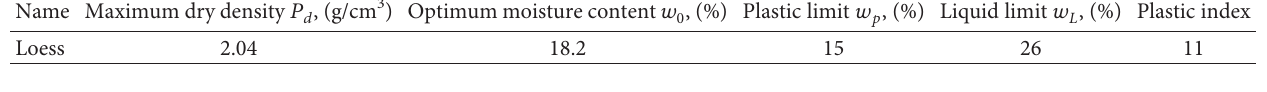
Table 2: The index of soil-based materials.